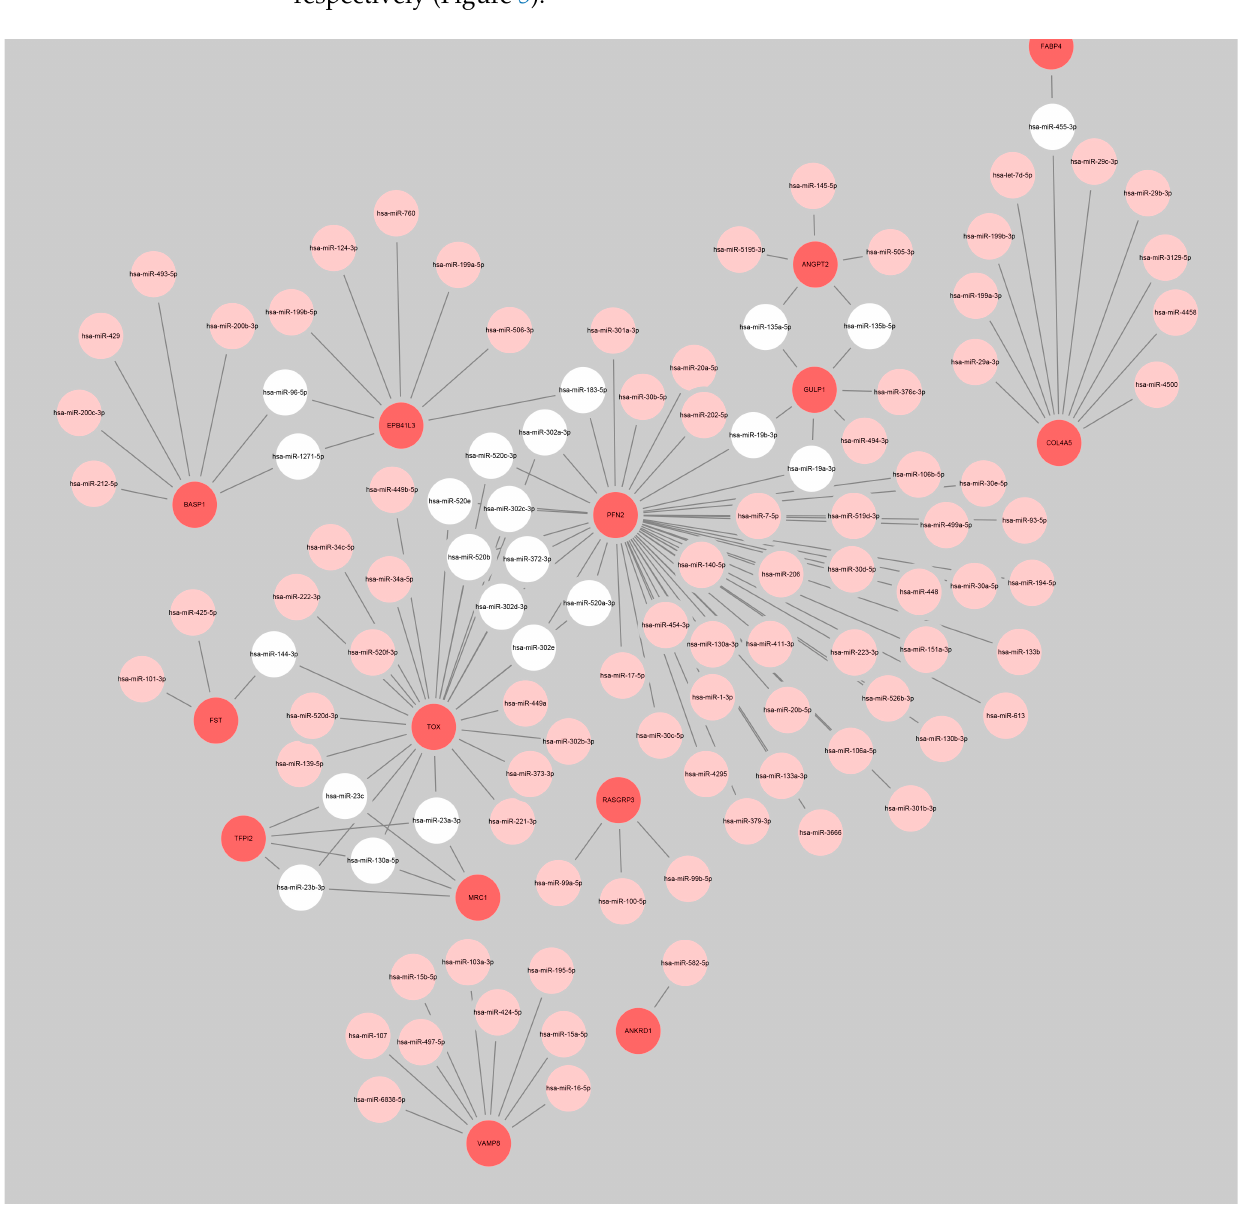
Figure 2. Network diagram of miRNAs regulating 23 significant DEGs. Bright red represents 23 significant DEGs, pink represents miRNAs, and white represents miRNAs that simultaneously regulate two or more significant DEGs.